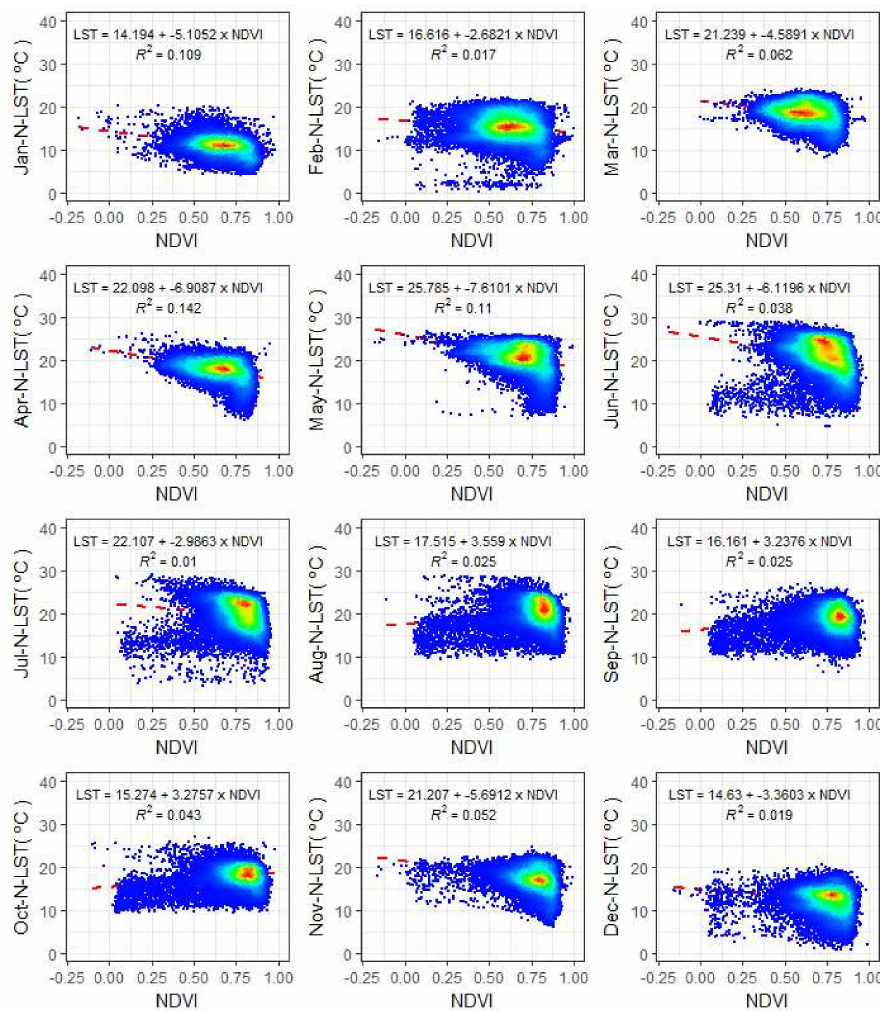
Figure A4. Scatter plots showing the relationship between the average monthly nighttime LST and NDVI in northwest Vietnam in 2015. The color ramp from blue to red expresses the point density from low to